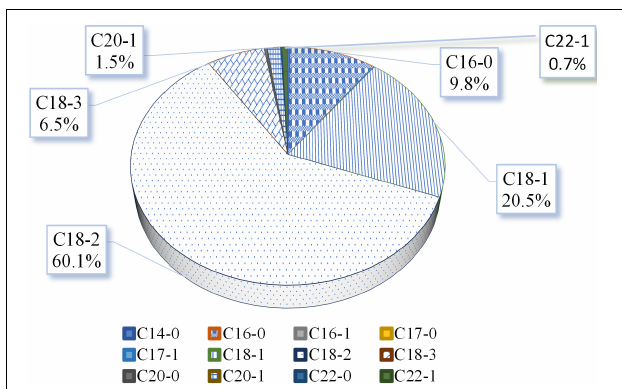
FIGURE 2 | Fatty acid composition of seeds harvested from five quinoa varieties grown in 2 years (2017 and 2018) on field experiments. Mean values are shown for each fatty acid quantified, and the values are presented as percentage (%). The fatty acids detected included the following: